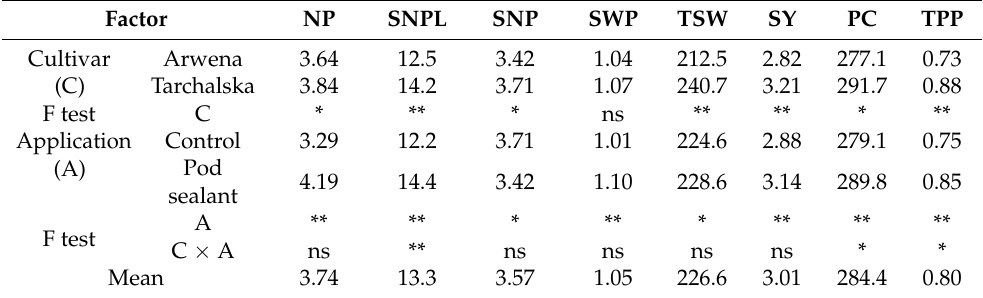
Table 4. Cultivar and pod sealant application effects on quantitative and qualitative traits in 2018.